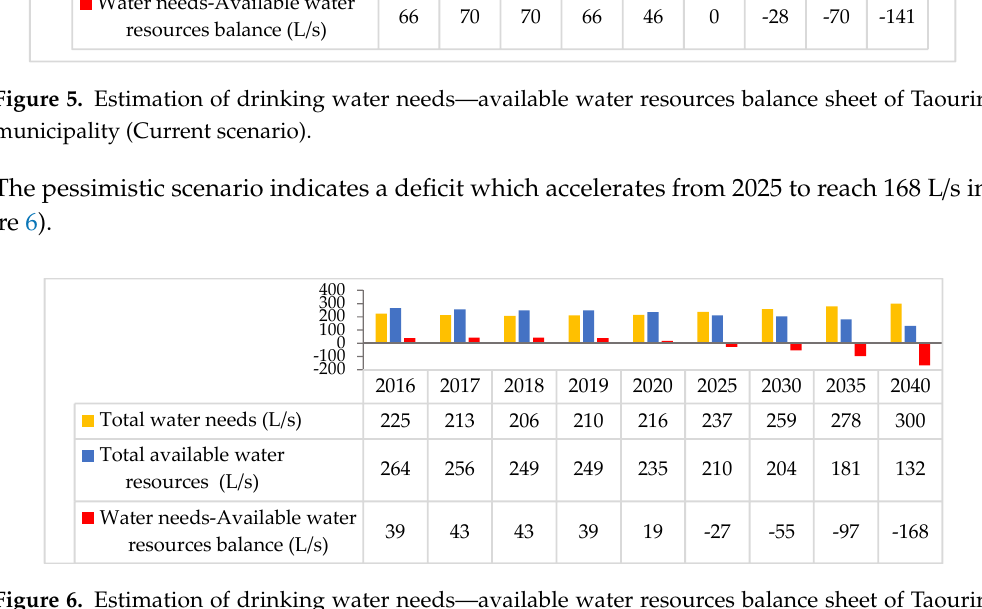
Figure 7. Productivity of T.O.C. aquifers: ( a ) Taourirt-Naima aquifer, ( b ) Bouhouria aquifer. 3.3. Characterization of the Groundwater Quality of the Taourirt-Oujda Corridor 